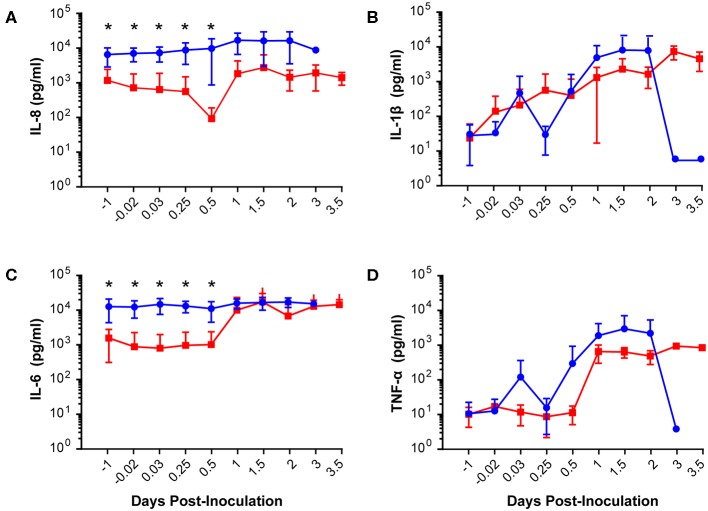
Amniotic fluid quantities of IL-8 (A), IL-1β (B), IL-6 (C), and TNF-α (D) are plotted at each time point. The GBS group is shown as solid blue circles and BSCI as solid red circles. Prior to experimental start and for the first 12 h of the experiment, quantities of IL-8 and IL-6 were significantly lower in the BSCI vs. the GBS group by Wilcoxon rank sum. *p < 0.05.